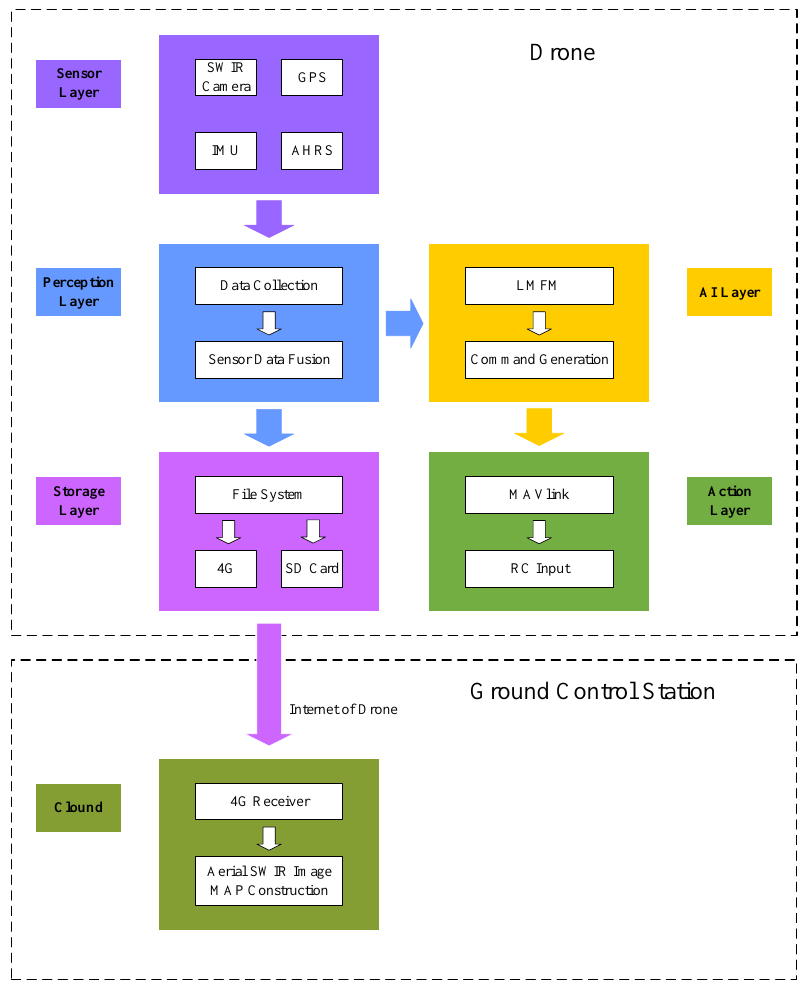
Figure 2. The structure of the whole system has five layers in the onboard computer. The aerial map construction process was performed in the ground control